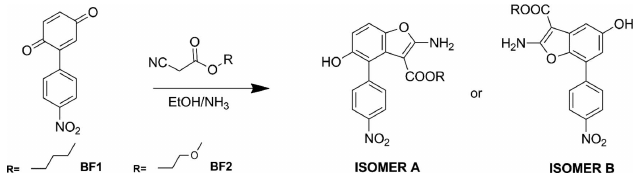
Figure 1 Reaction scheme for the preparation of benzofuran derivatives BF1 and BF2: the reaction could afford two different